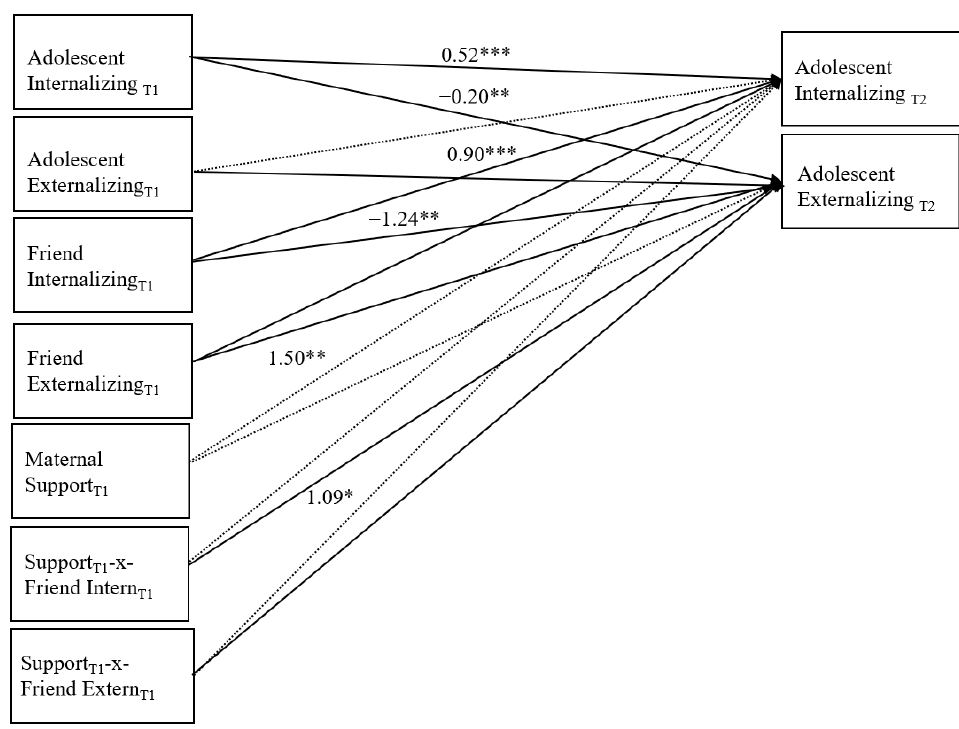
Figure 2. Final path model with maternal support.* p < 0.05, ** p < 0.01, *** p < 0.001 Path coefficients represent the standardized results. Non-significant paths remain in the model and are displayed as dashed lines. Within-time covariances are not displayed for ease of communication, but were tested in the model and reported